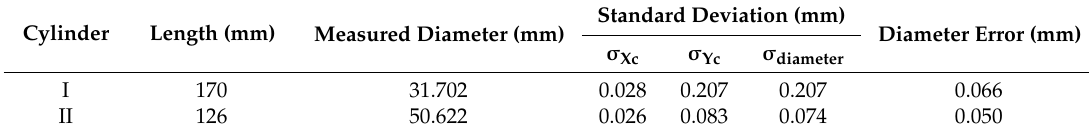
Table 6. Measures of the two metallic cylinders and results of the circle